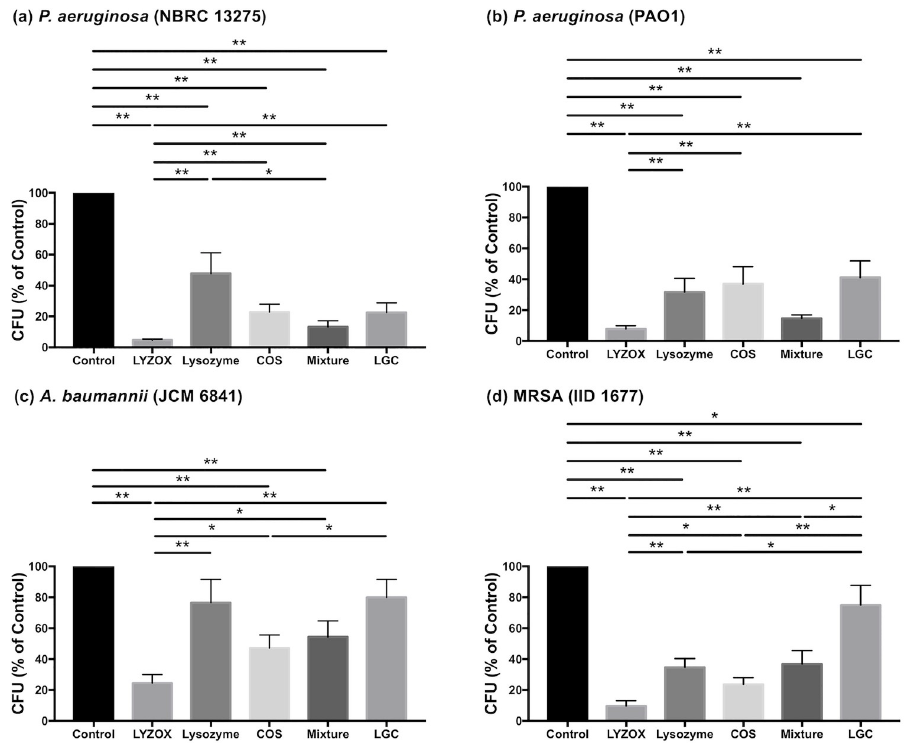
Fig 2. Growth inhibition test. (a) Pseudomonas aeruginosa (NBRC 13275), (b) Pseudomonas aeruginosa (PAO1), (c) Acinetobacter baumannii (JCM 6841), (d) MRSA (IID 1677). Each type of bacteria was incubated with LYZOX solution (2,000 μ g/mL), lysozyme solution (1,000 μ g/mL), chitosan oligosaccharide (COS) solution (1,000 μ g/mL), the mixed solution (lysozyme solution [1,000 μ g/mL] and COS solution [1,000 μ g/mL]) or lysozyme-galactomannan conjugate solution (2,000 μ g/mL) in tryptic soy broth (TSB) at 37 ˚C for 6 h. The dilutions were plated, the colonies were counted following growth overnight, and results were compared with the control. The control was TSB without each treatment. The values are the mean ± SEM from 18 independent experiments for P . aeruginosa (NBRC 13275). The values are the mean ± SEM from eight independent experiments for P . aeruginosa (PAO1), A . baumannii and MRSA. � p < 0.05, �� p < 0.01 (unpaired t-test). LYZOX: lysozyme-chitosan oligosaccharide conjugate. LGC: lysozyme- galactomannan